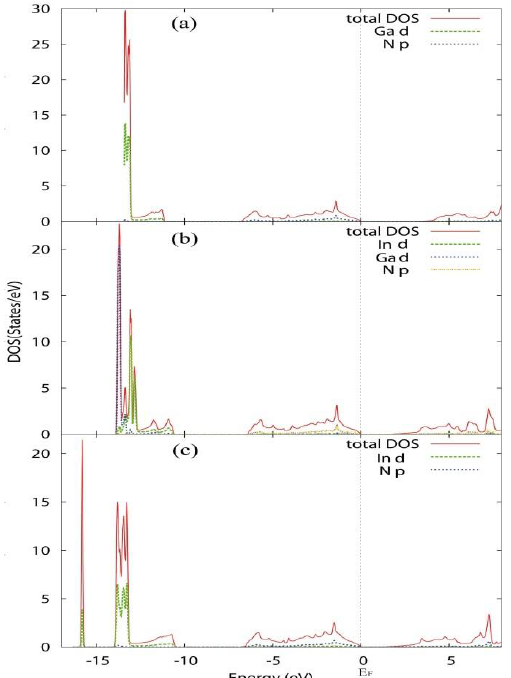
Fig. 2. The total DOS and PDOS in WZ phase for (a) GaN, (b) and (c) InN.